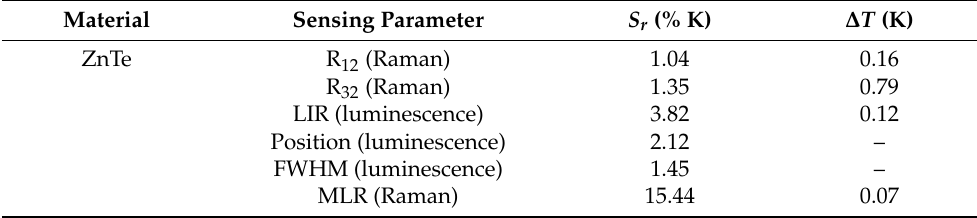
Table 2. Thermometric performances of ZnTe crystal using different sensing parameters ( T = 50